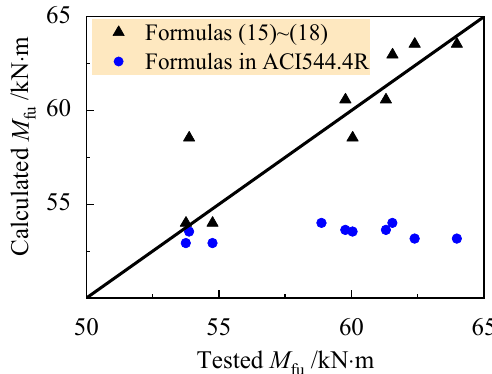
Figure 17. Tested and calculated ultimate moment of reinforced SFR-CRAC beams.